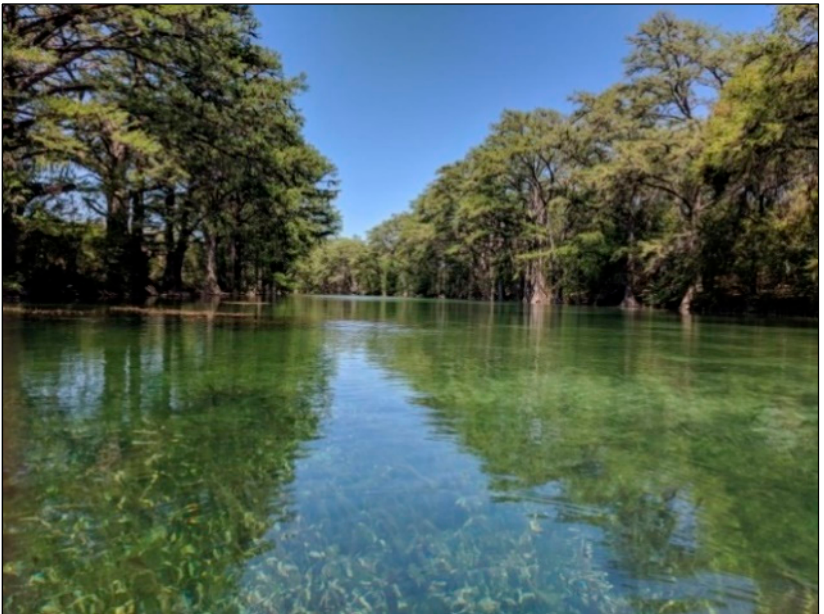
Figure 4. Frio River and its scenic environment, surrounded by overhanging trees along the riparian zone.